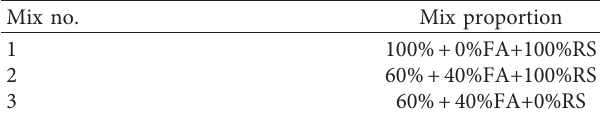
Table 5: Mix proportions for